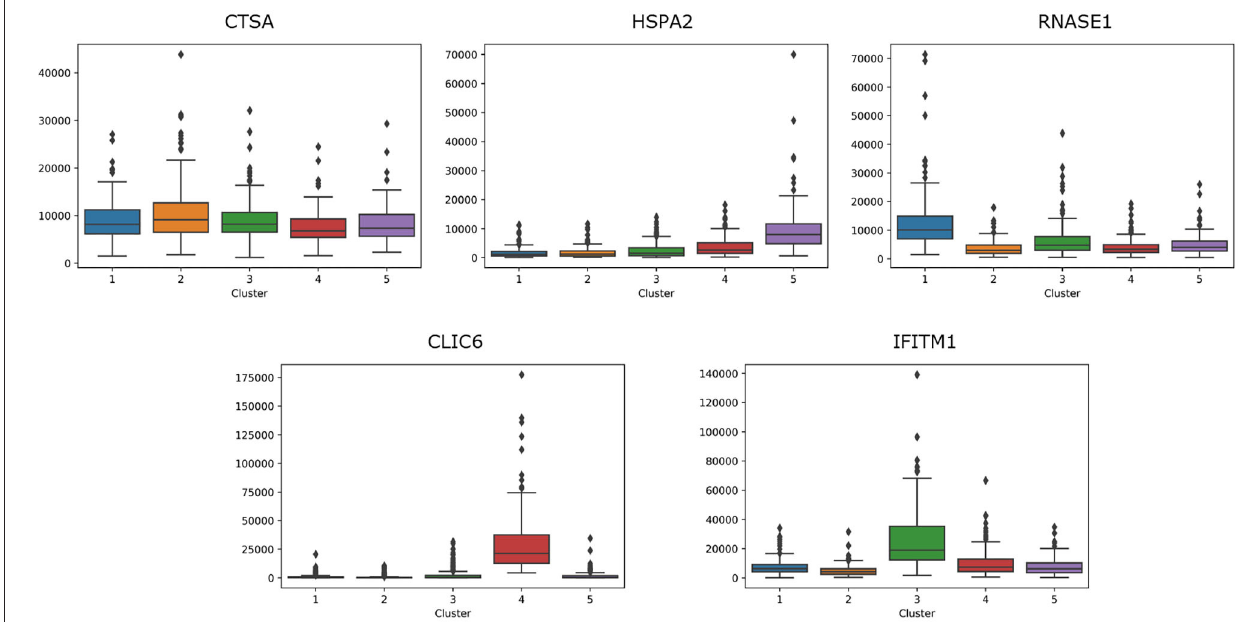
FIGURE 7 | The box plot of essential gene expression data for breast cancer.